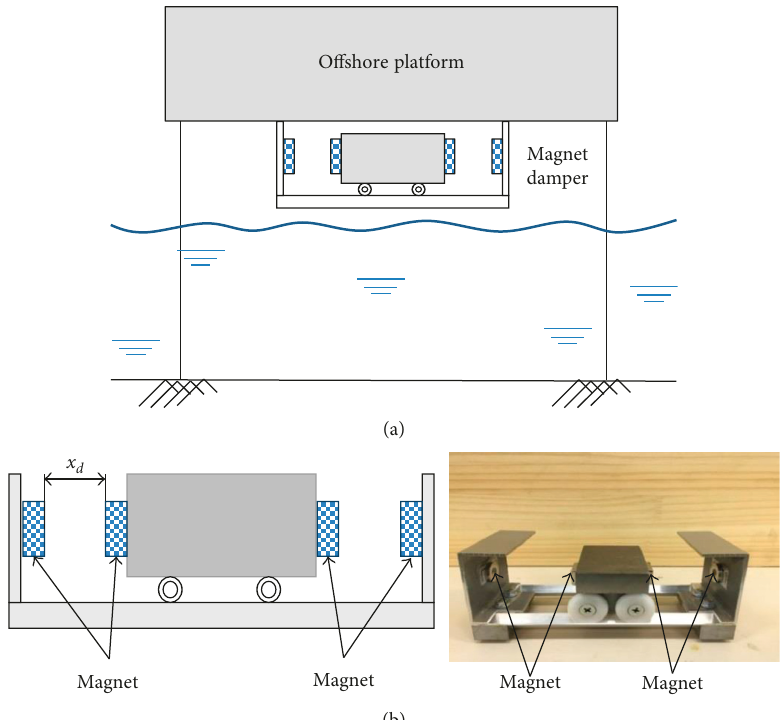
Figure 2: Experimental model of the magnet TMD. (a) Jackup offshore platform with a magnet TMD; (b) model of magnet